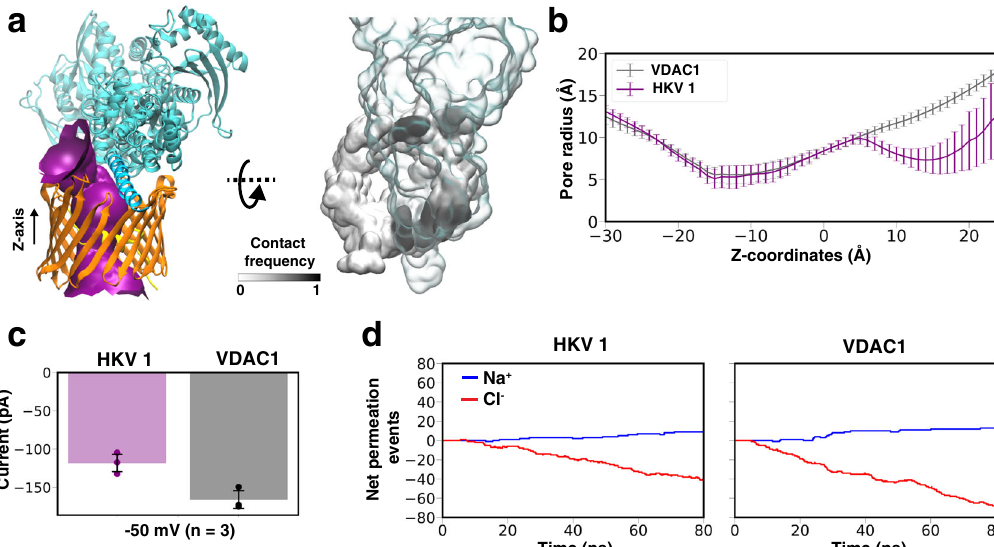
Fig. 4 HKII/VDAC1 interaction in Complex HKV1. a Purple surface showing VDAC1 pore radius pro fi le in HKV1, made with the program HOLE 95 (left panel). Z -axis represents the membrane normal. (Right panel) Top-down (cytosolic) view of contact frequencies of HKII (transparent representation) mapped onto the surface of VDAC1 (black and white), calculated using the last 450 ns of MD simulation of both replicas. b The average radius pro fi le of the VDAC1 pore calculated using HOLE 95 for both VDAC1 alone, and its complex with HKII (Complex HKV1). c The in silico VDAC1 current at − 50 mV for a membrane-equilibrated VDAC1 alone or the VDAC1/HKII HKV1 complex calculated from electric- fi eld MD simulations. The mean and standard deviation of current for each system were calculated from three independent simulations. d The cumulative net number of channel-crossing events by Cl − (red traces) and Na + (blue traces), tracked over the time course of a representative MD simulation for VDAC1 or the HKV1